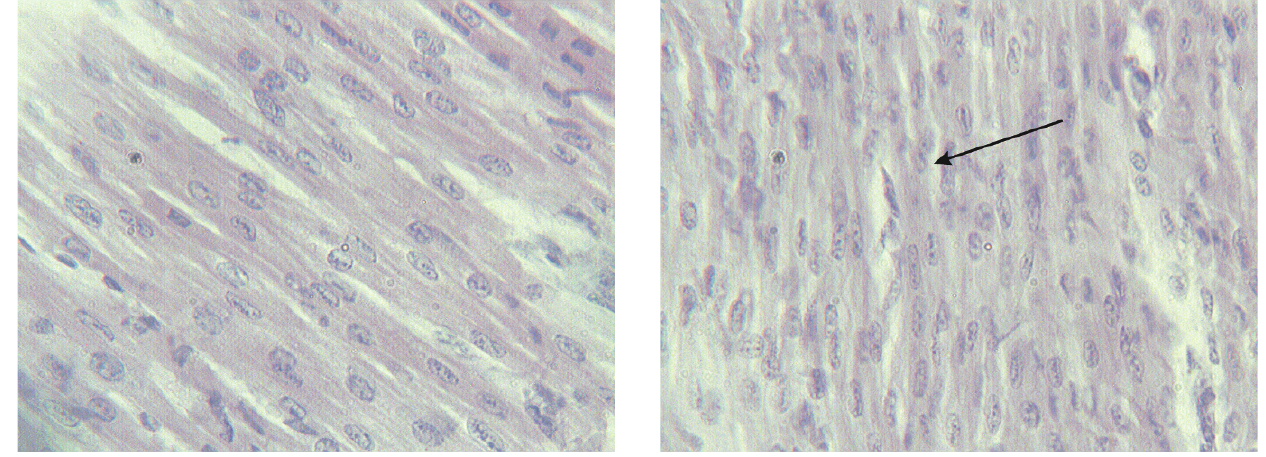
Figure 4 - Nuclear polymorphism and